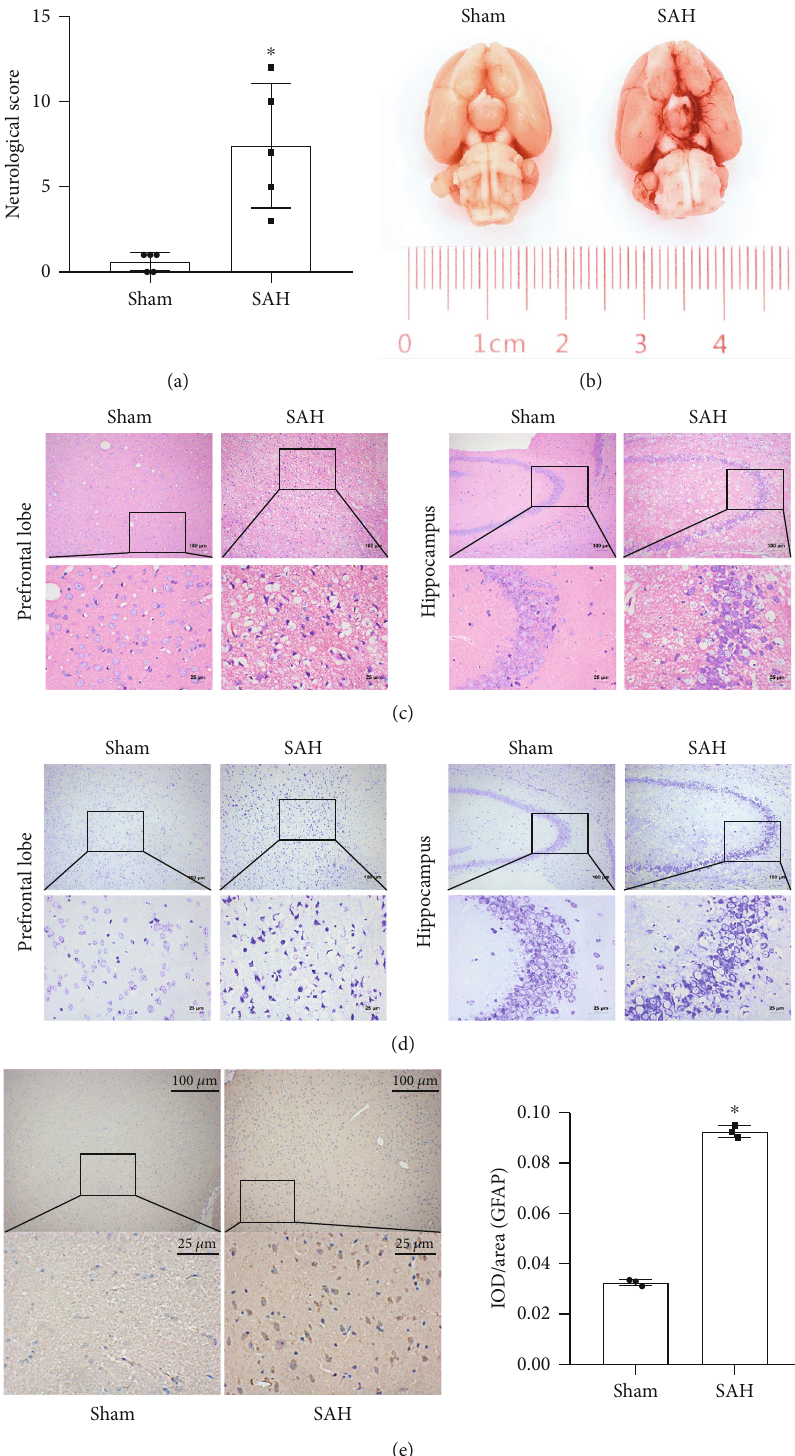
Figure 1: Pathological features of the SAH model. (a) Quantitative analysis of neurological scores. (b) Representative brains from the sham and SAH groups. (c) HE staining. (d) Nissl staining. (e) Immunohistochemical was used to detect of positive expression of activated astrocyte marker GFAP+. ∗ Compared with the sham group, P < 0 : 05 . The above results were all measurement data, expressed as mean ± SD , and an unpaired t -test was used between the two